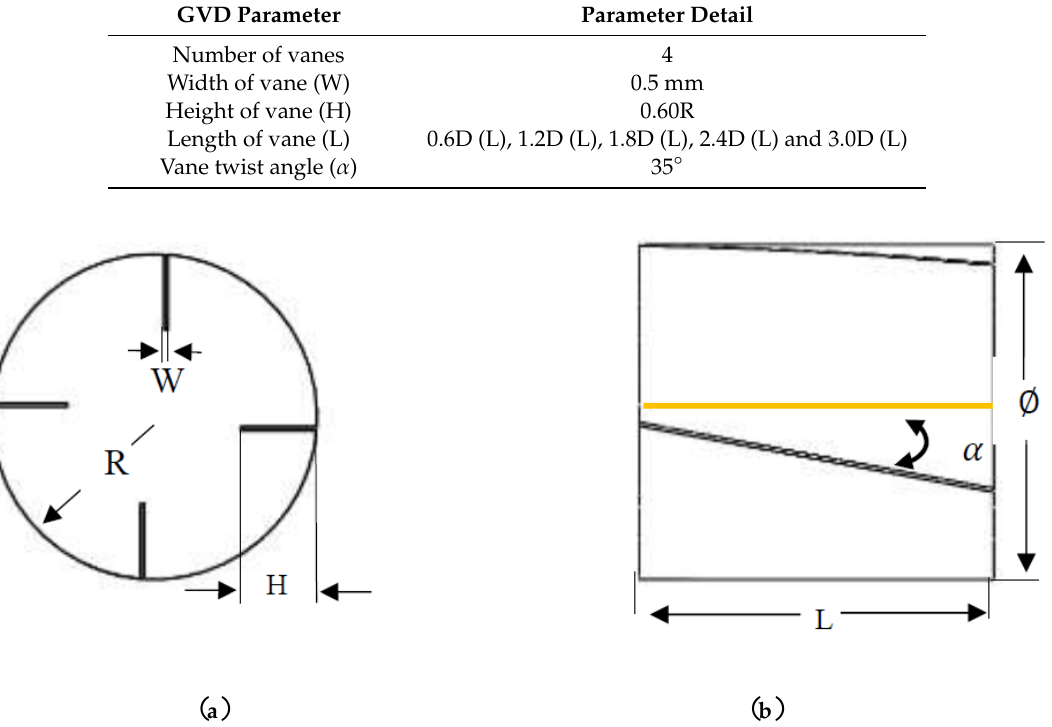
Figure 2. The GVD design: ( a ) front view and ( b ) side view. Table 2. Specification parameters of the GVD.